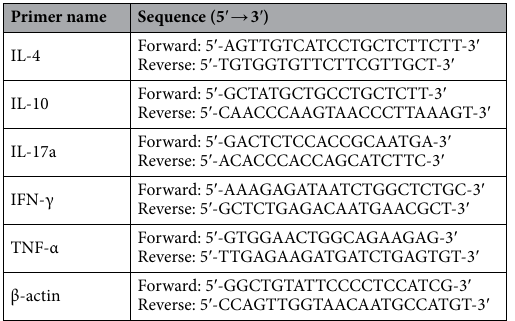
Table 2. The sequence of primers used in the current study. IFN interferon, IL interleukin, TNF tumor necrosis factor.